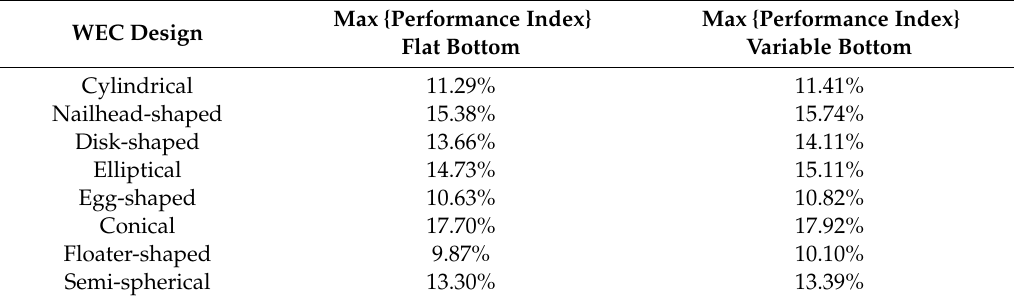
Table 1. 1-DOF WEC shapes and PI for flat and variable bottom topographies ( h 1 = 1.2 m, h 3 = 0.8 m, α = bot